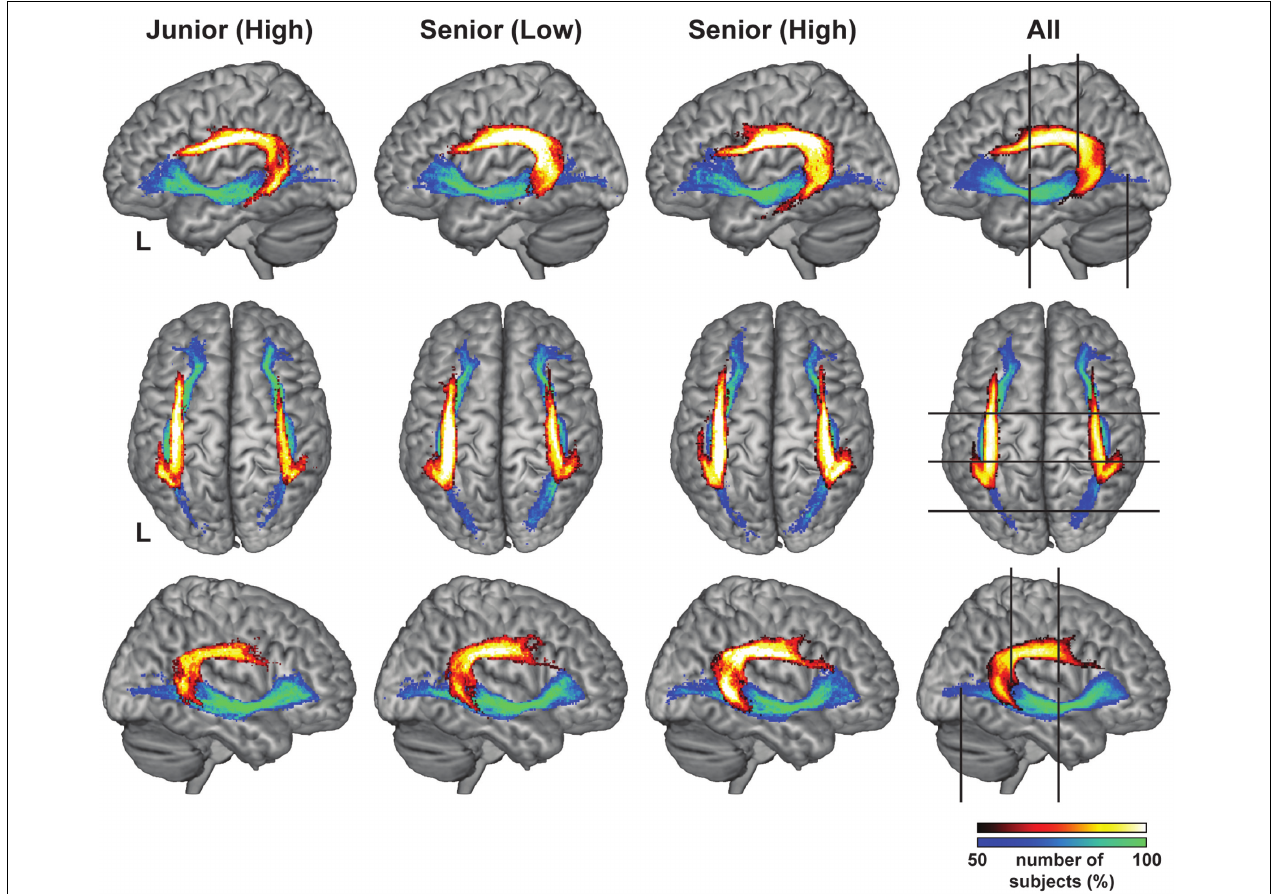
FIGURE 2 | The Arcuate and IFOF reconstructed with diffusion MRI. The probability maps of population for the Arcuate and IFOF in the MNI space. The pathways were thresholded to show the results of the tracking present in more than half of the participants in each group. The color scales denote the number of participants (%): black–red to yellow–white for the Arcuate, and blue to green for the IFOF. Note that the Arcuate in the Senior (High) and Senior (Low) groups was clearly thicker than that in the Junior (High) group, which was evident from both left lateral (top row) and top (middle row) views. Similar tendency was observed in the right hemisphere from the right lateral (bottom row) view. To examine the overall profile while excluding highly variable regions among individuals, we first set candidate regions for selecting regions of interest (ROIs): a region of 35 mm for the Arcuate ( y = –40 ∼ –6), and a region of 70 mm for the IFOF ( y = –75 ∼ –6). The right-most panel shows the candidate regions, which are bounded by the pairs of black lines. We further selected ROIs at the portion with the most uniform thickness in each pathway to quantify the Arcuate and IFOF (see the “Materials and Methods” section), as shown in Figure 3